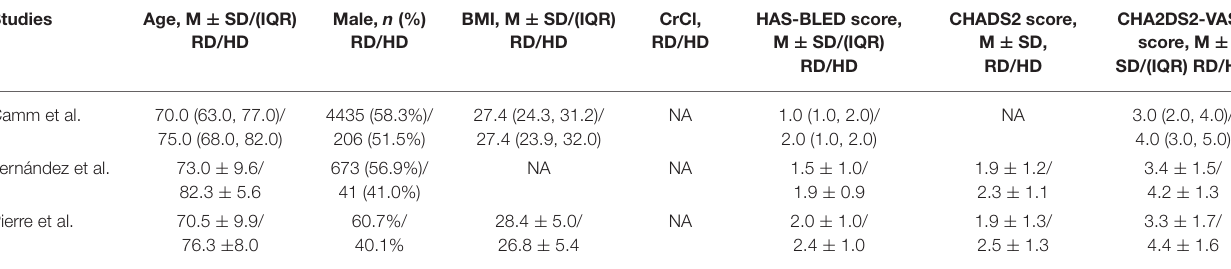
TABLE 5 | Baseline characteristics of recommended dose and non-recommended high dose of NOACs.